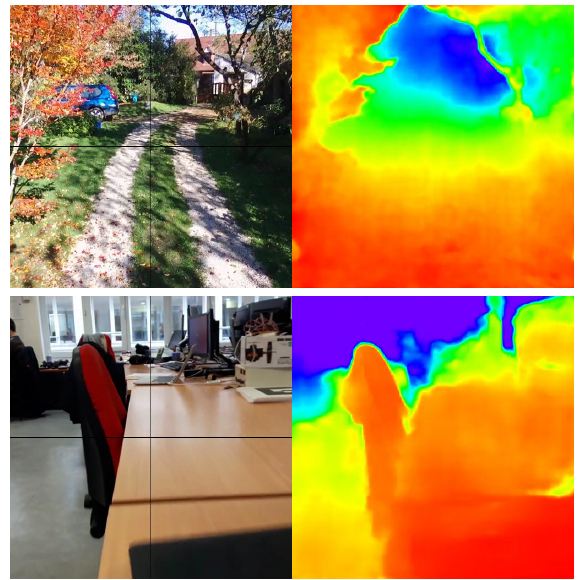
Figure 7. some results on real images input. Up is from a Bebop drone footage, down is from a gimbal stabilized smartphone